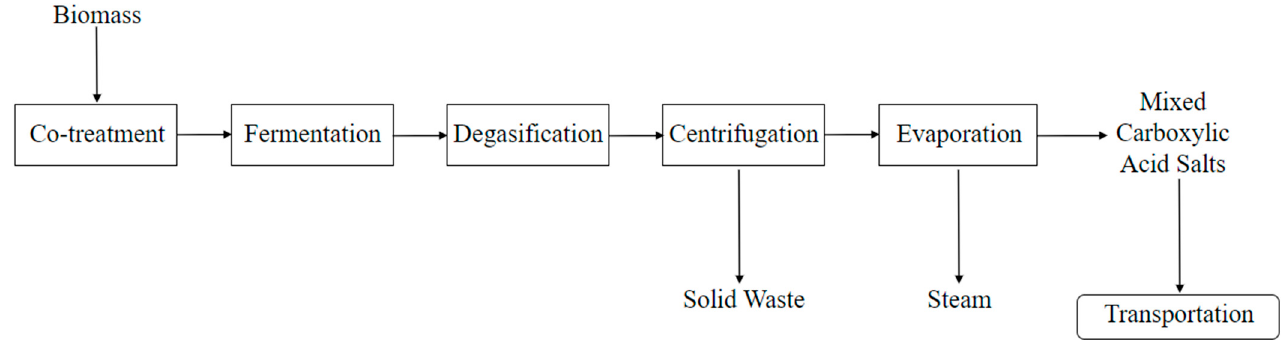
Figure 1. Process diagram of the current design.